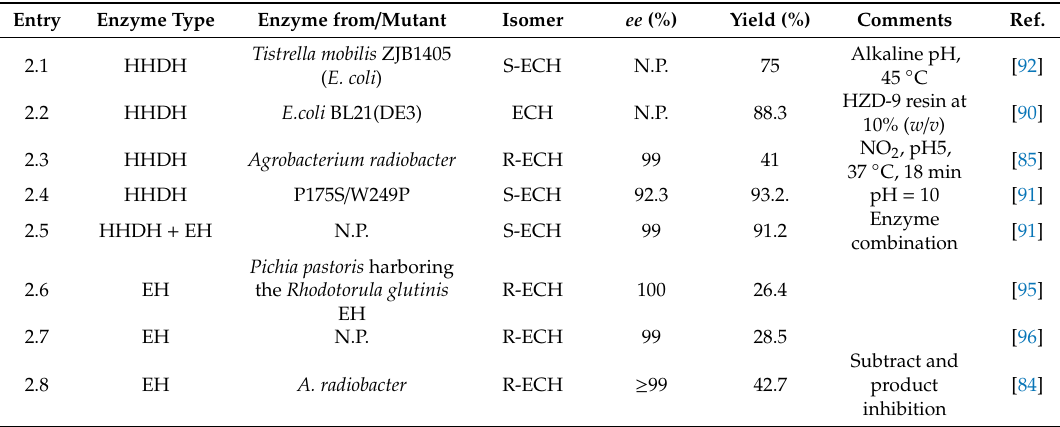
Table 2. ECH synthesis using biotechnological